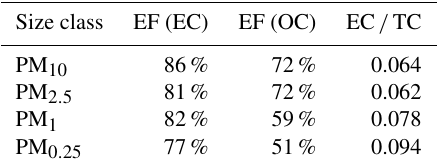
Table 7. Relative contribution of EFs (EC and OC) for wood burn- ing per size class to total